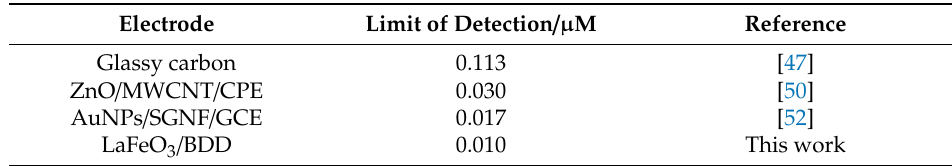
Table 3. Comparison of the limit of detection for CCB electrochemical detection using a di ff erent electrode